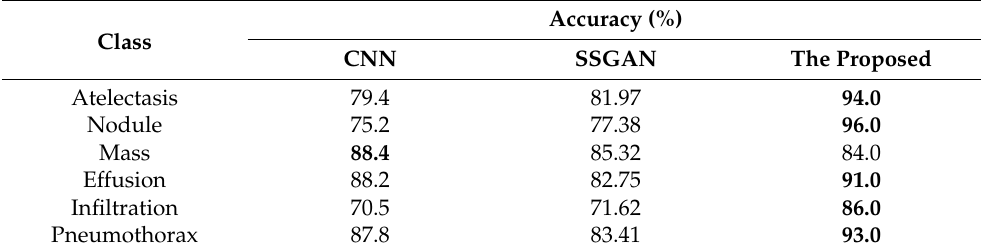
Table 2. Classification accuracy of different models for individual classes.